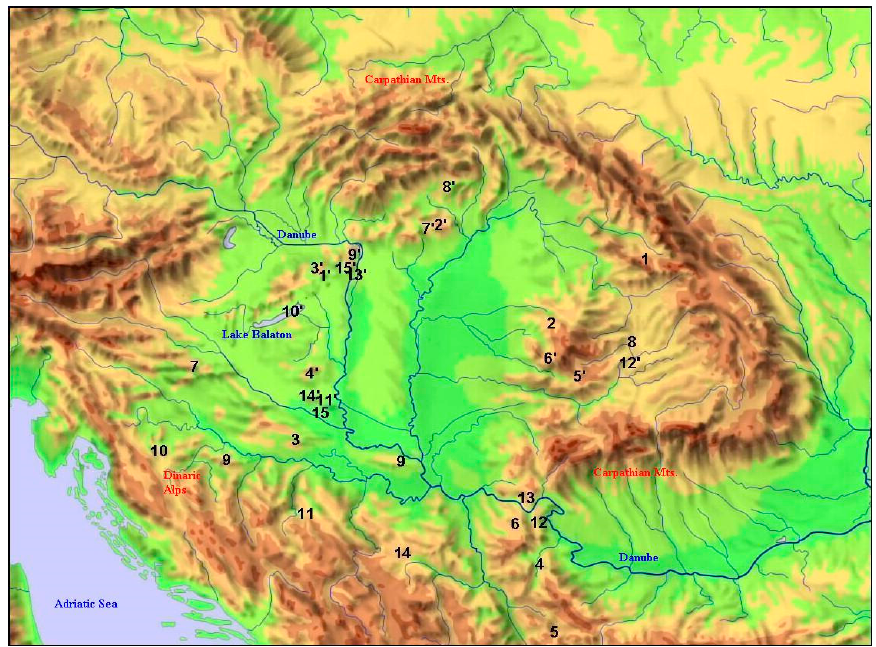
Figure 3. Distribution of the northernmost and nearest southern occurrence-pairs of the selected 15 species (simplified to the supposed version in the case of more than one track). Numbers refer to species in Table 1.